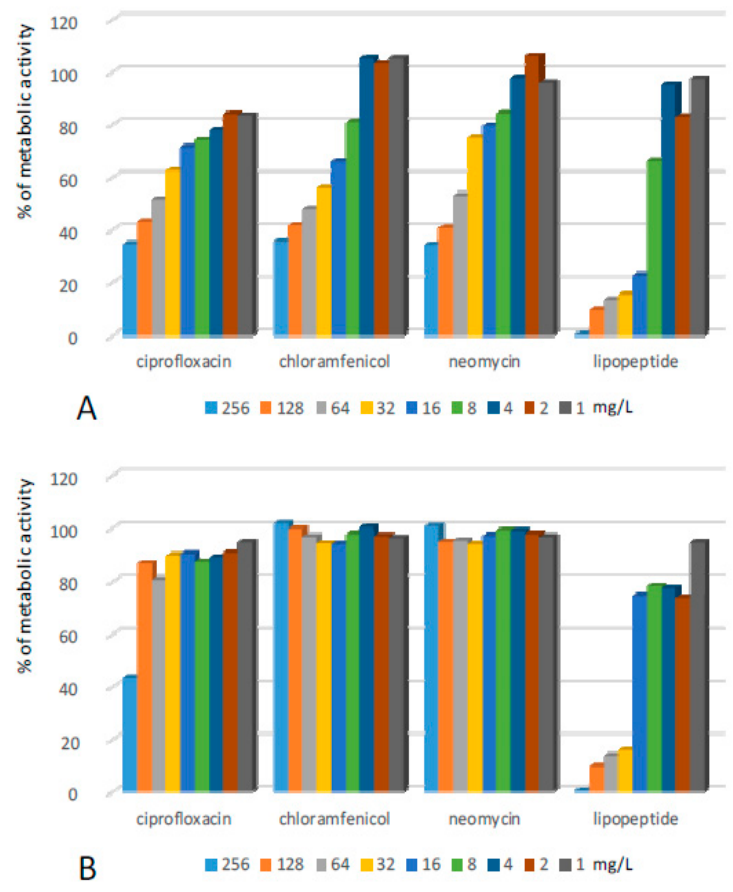
Figure 3. Activity of the lipopeptide and conventional antimicrobials applied at concentrations of 1–256 mg/L against EF biofilms formed on polystyrene ( A ) results read after 24 h exposure to compounds; and ( B ) results read after the withdrawal of compounds and an additional 24 h of incubation in MHB II. The results are presented as the percentage of metabolic activity in comparison to positive (100%) and negative (0%) controls; RSD ≤ 15%.